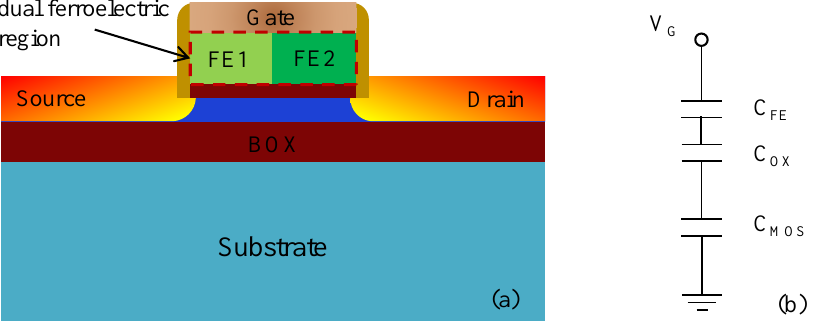
Figure 1. ( a ) Schematic of the DFR-NCFET, ( b ) equivalent capacitance model of NCFET.